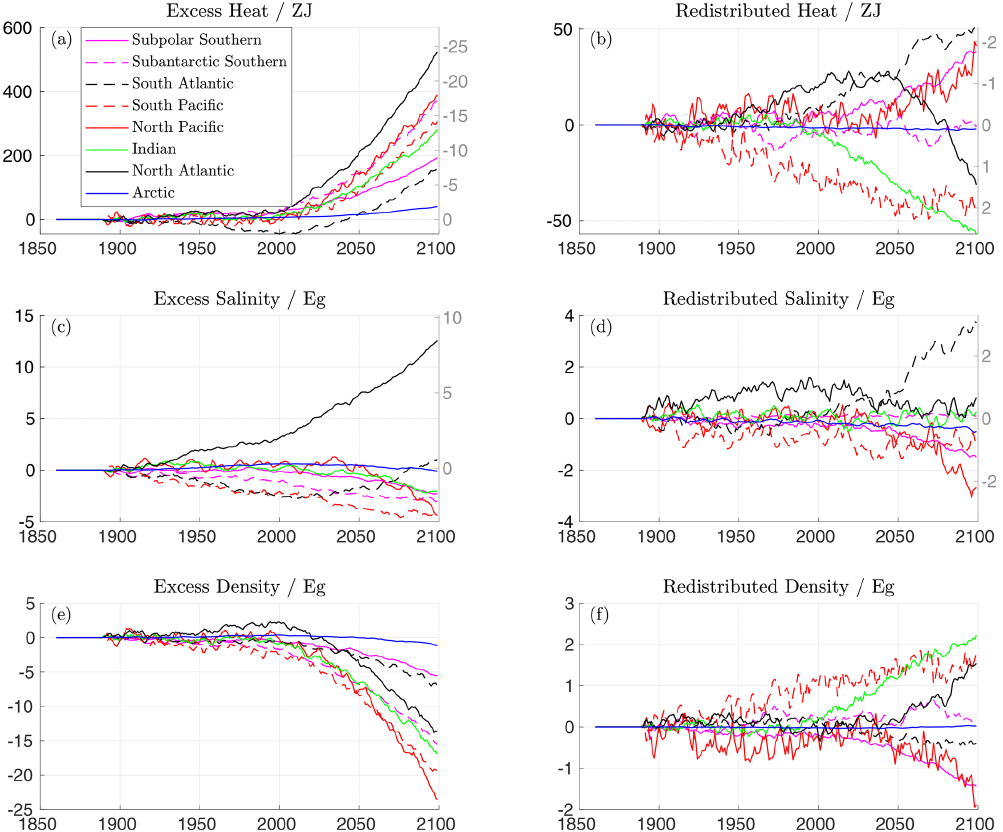
Figure 6. Excess (left column) and redistributed (right) heat, salinity, and density integrals for each ocean basin over the full model run. For the changes in heat and salinity in panels (a–d) , the equivalent integrated density change (Pg) is given in grey on the right. Scales differ for excess and redistributed components, and changes in salinity and density are given as mass changes rather than